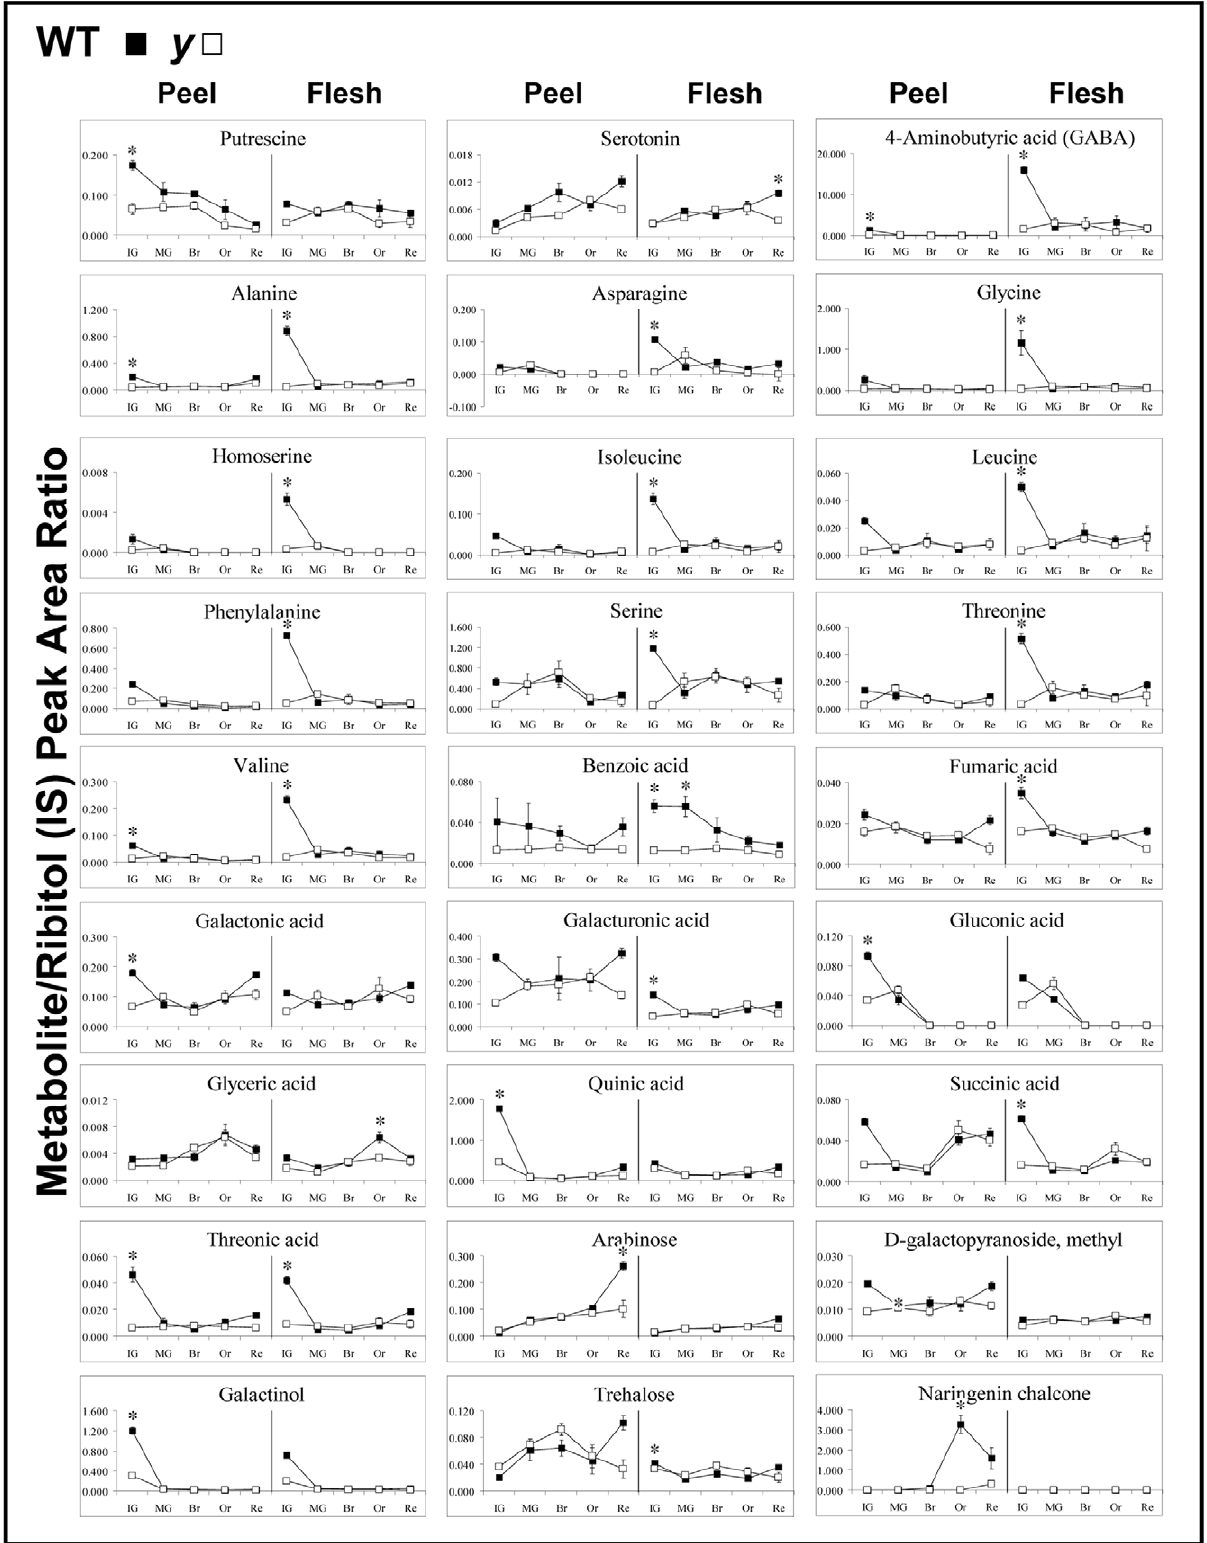
Figure 4. GC-MS analyses detected 27 out of 56 assigned polar metabolites (Mintz-Oron et al. [ 6 ] ) as having significantly different levels between wt and y mutant peel and/or flesh at at least one tested stage of fruit development. Indicated by asterisks are significant differences as analyzed by two-way ANOVA and post-hoc analyses, see Materials and Methods (n=3 for each sample). Y axis indicates metabolites’ relative quantification by normalization of their response values to the Ribitol internal standard (IS) (see also Mintz-Oron et al. [6]).